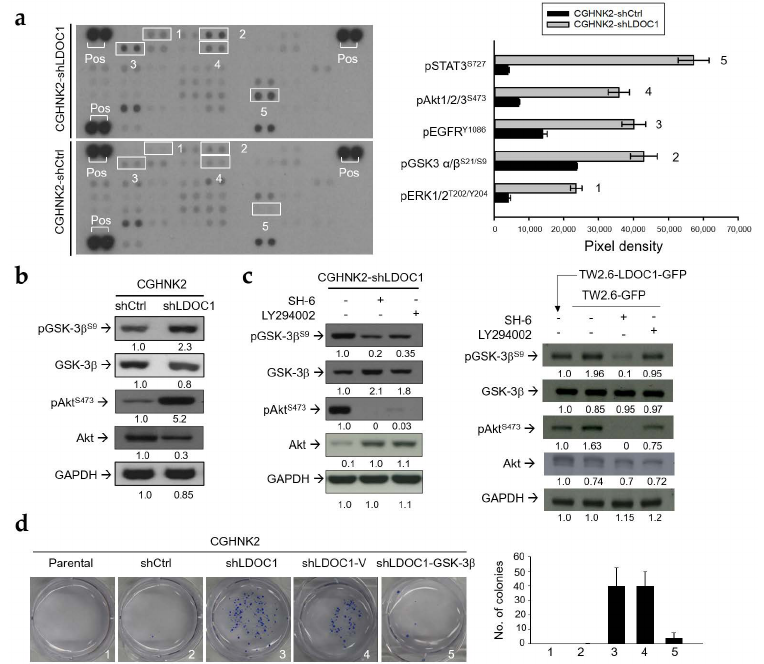
Figure 5. LDOC1 downregulation leads to inhibitory phosphorylation of GSK-3 β S9 by pAkt S473 and GSK-3 β regulates the clonogenicity of the CGHNK2-shLDOC1 cell line. ( a ) Results of the